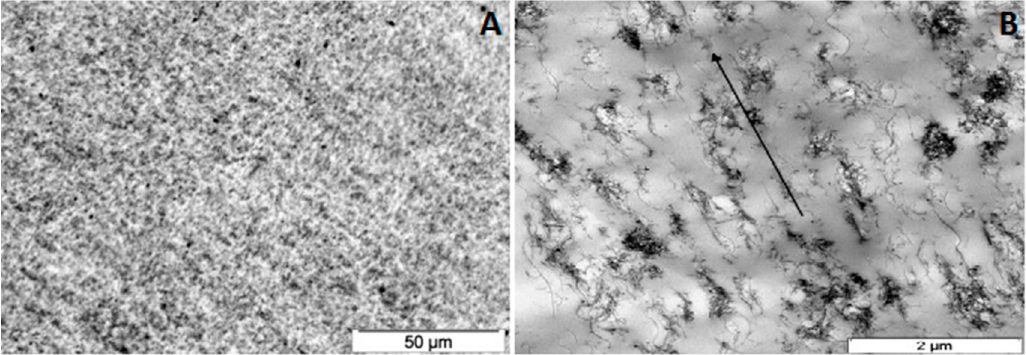
Figure 4. Optical microscopy image of a PLA/MWCNT 3 wt % mixture produced by twin-screw extrusion ( A )—illustrating the high degree of macroscopic filler dispersion. Transmission electron microscopy image of a PLA/MWCNT 3 wt % mixture produced by twin-screw extrusion, followed by piston spinning; ( B )—arrow indicates that fillers are strongly oriented in fiber direction due to the spinning process [185].